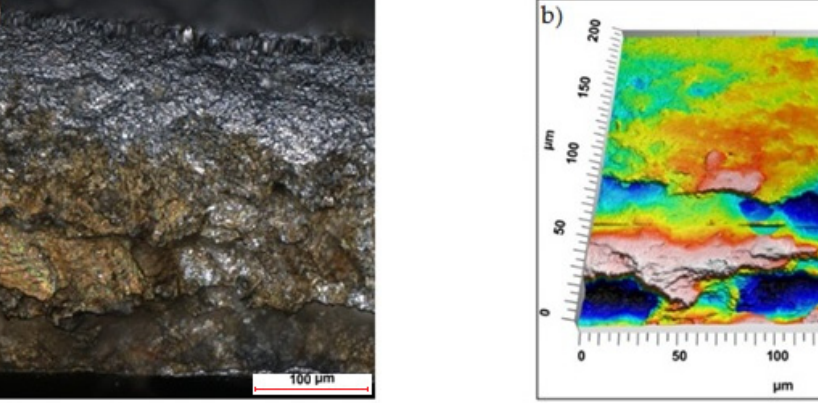
Figure 4. Views of the surface of the cut edge ( h c = 0.04 mm and v = 10.2 m/min): ( a ) surface photography, ( b ) surface topography (coated steel).